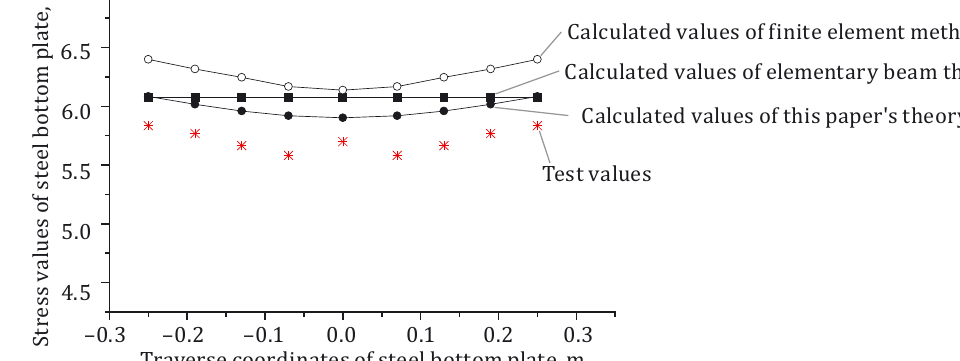
0.3 Figure 8. The stresses of steel bottom plate under uniform load